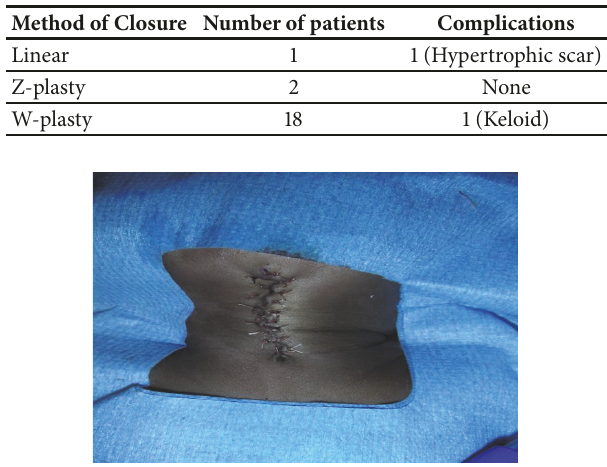
Figure 3: W-plasty after wound